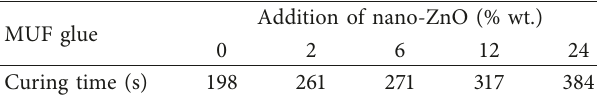
Table 1: Curing times of MUF glues treated with zinc oxide nanoparticles determined at 100 ° C. Addition of nano-ZnO (% MUF glue